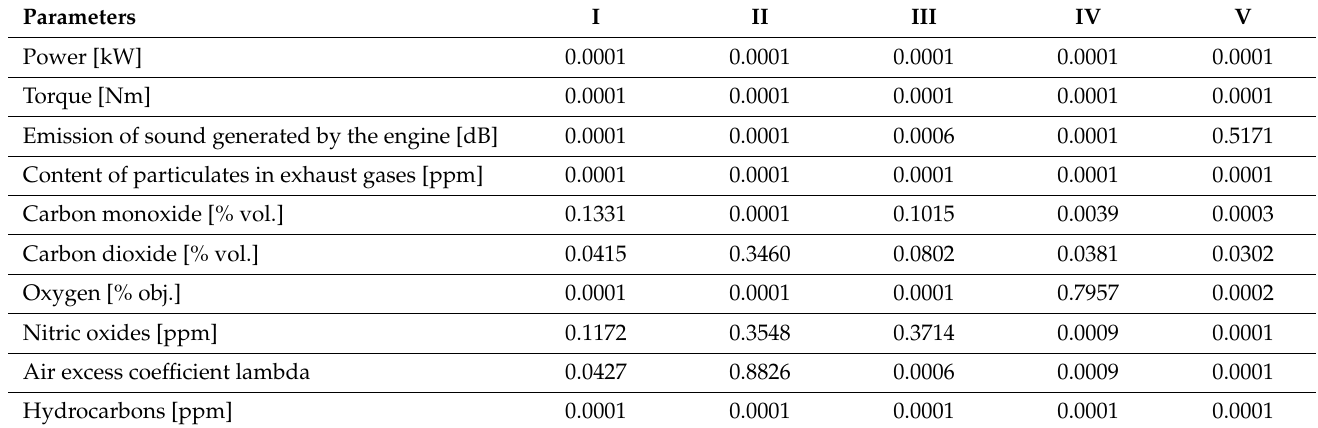
Table 9. Verification of the hypothesis for the analyzed parameters